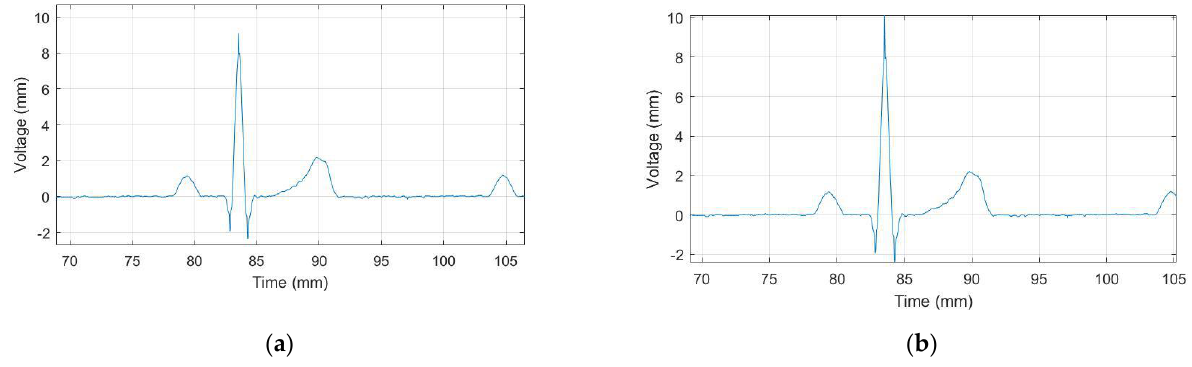
Figure 11. A portion of the reconstructed ECG signal (normal sinus rhythm, 60 bpm, II lead) with SF application; ( a ) before the amplitude correction; ( b ) after the amplitude correction.